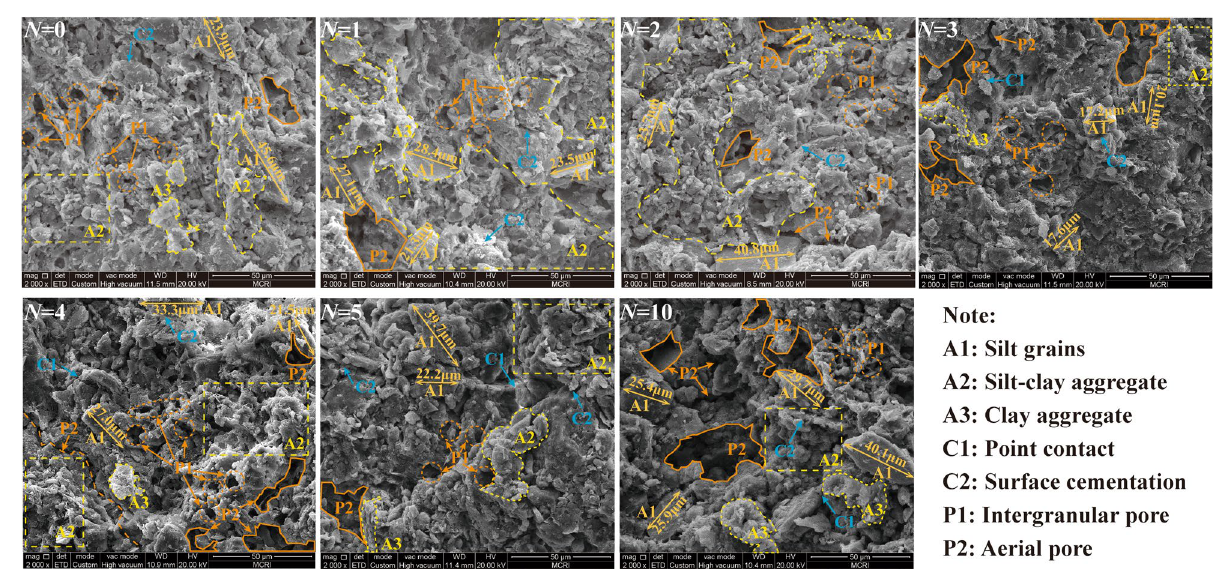
Figure 6. SEM images of BML under W–D cycles ( N ) (×